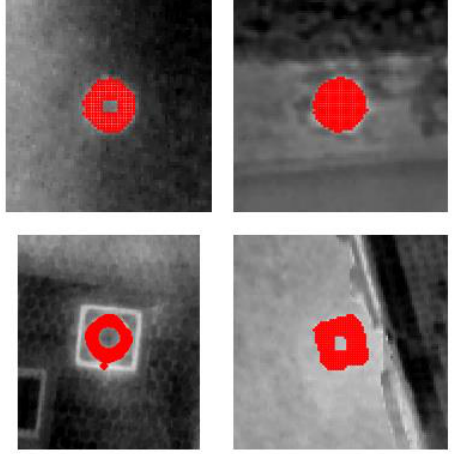
Figure 6 Anomaly examples – manholes